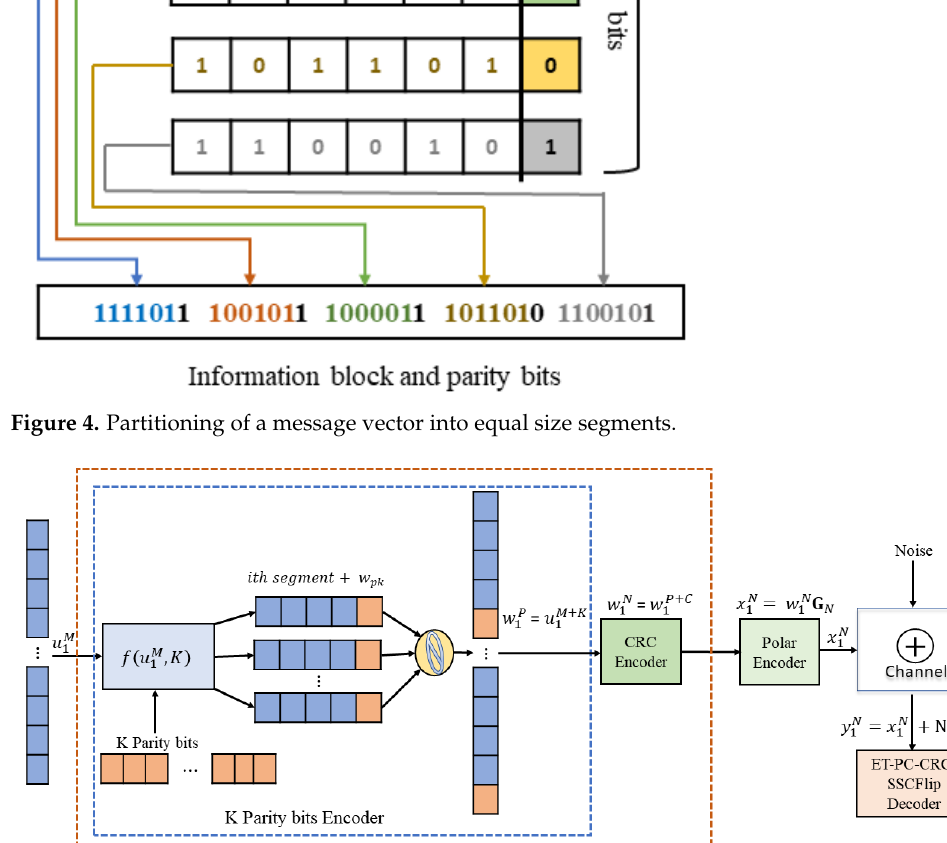
Figure 5. Schematic view of a triple-layer concatenated PC-CRC polar coding